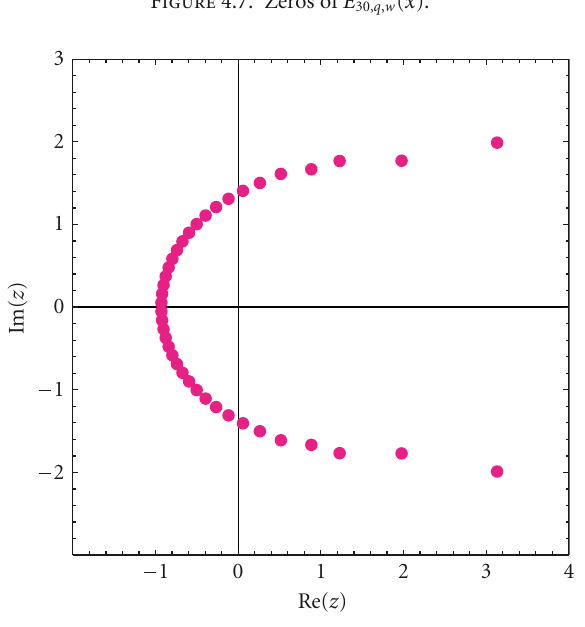
Figure 4.7 . Zeros of E 30, q , w ( x ).